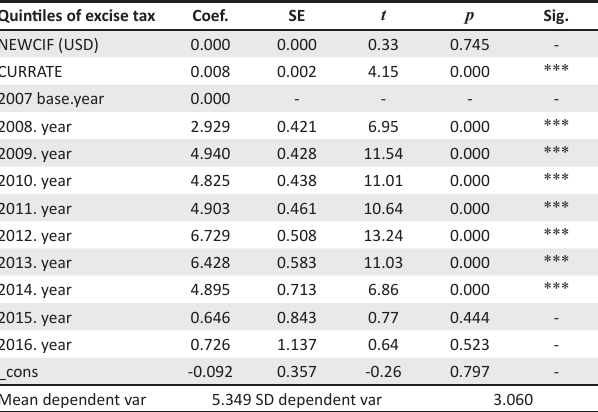
Mean dependent var